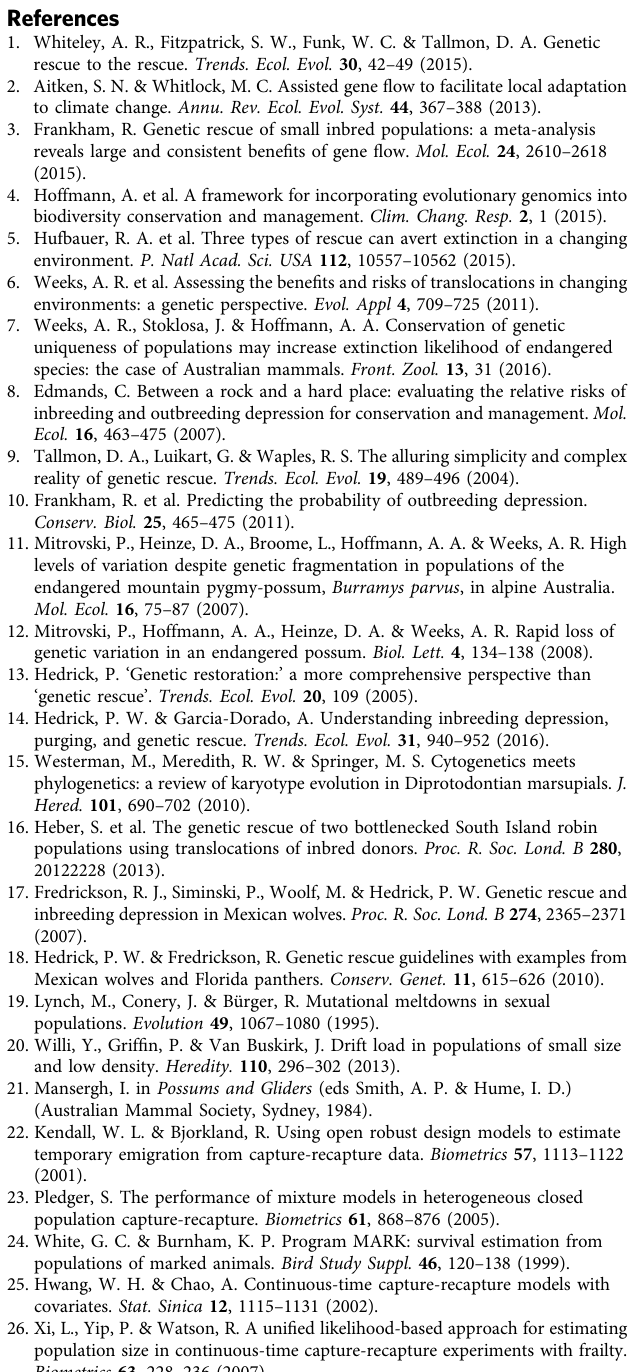
Code availability . R scripts for the mark-recapture analyses are available in the Supplementary Information fi le as Supplementary Methods. Data availability . New microsatellite loci sequences are available in GenBank (accession numbers MF568684-MF568699). The genotypic data that support the fi ndings of this study are available from the Dryad Digital Repository (http://dx. doi.org/10.5061/dryad.7g988) 36 . All the other data that support the fi ndings of this study are included in the manuscript and supplementary fi les or are available from the corresponding author (A.R.W.) upon reasonable